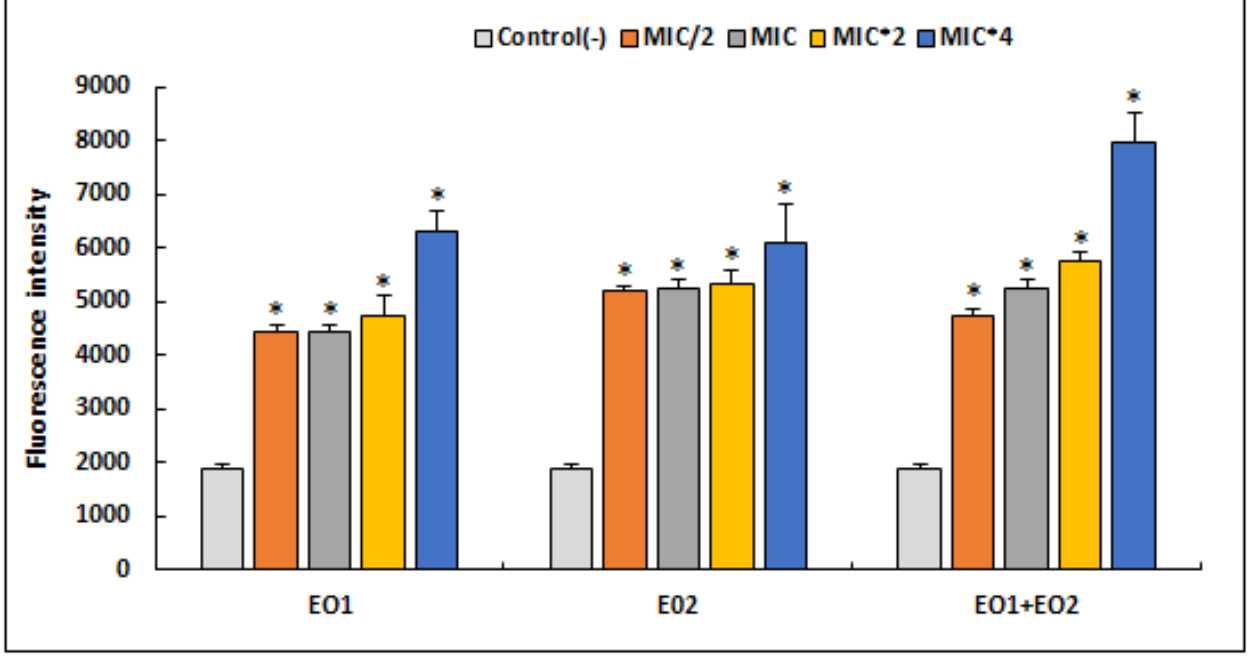
Figure 2. Quantitation of intracellular ROS production by S. aureus ATCC 25923 after 24 h treatment with different concentrations of R . officinalis (EO1) and M. communis (EO2) essential oils and their combination (EO1 + EO2), using the DCFA-DA probe. Results are expressed as mean fluorescence intensity ± SD. Asterisks represent significant difference ( p < 0.05) between each treatment with the negative control.